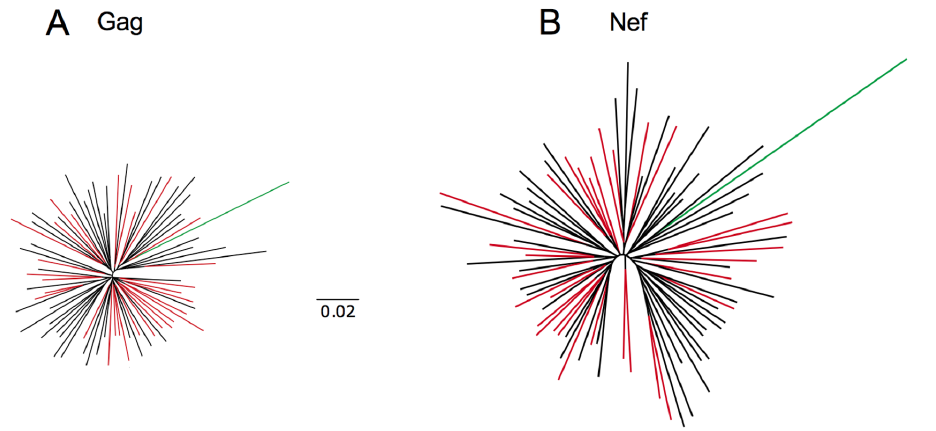
Figure 1. Sequence analyses of HIV-1 Gag and Nef from treatment and placebo arms. Maximum-likelihood phylogenetic trees of bulk Gag sequences (Panel A) and clonal Nef sequences (panel B) from participants who received 1% tenofovir gel (red) or placebo (black) demonstrated no major clustering between arms of the trial. HIV-1 subtype B reference sequence HXB2 is shown in green.